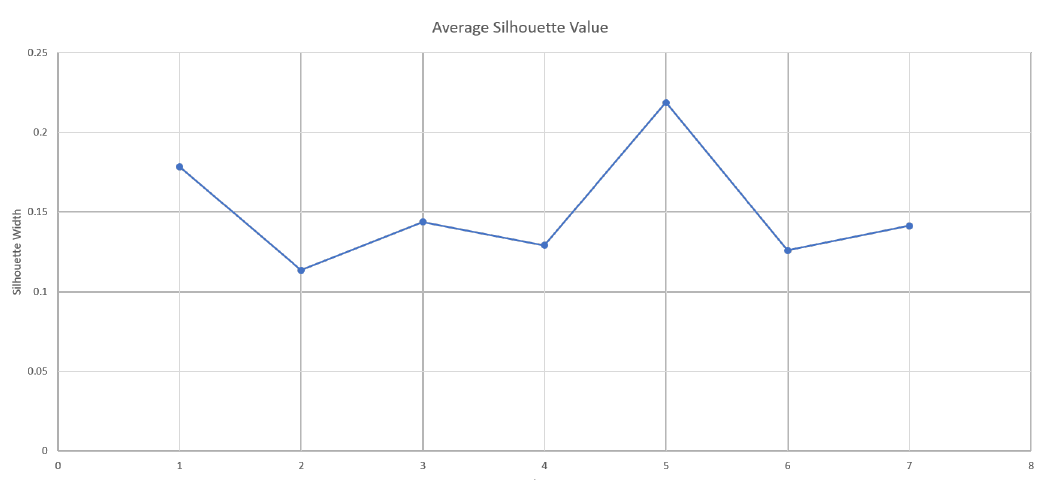
Figure 2. The average silhouette value—the figure shows the average silhouette value ranged between 0.12 and 0.22, for each cluster